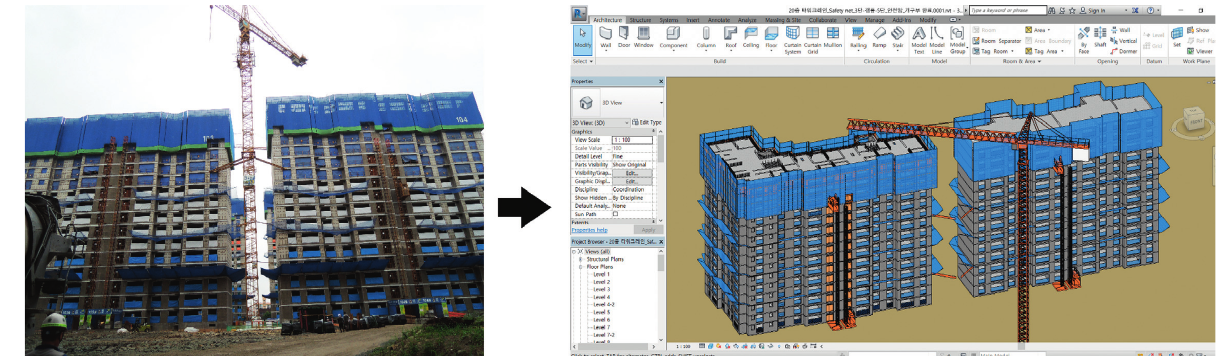
Figure 3: Front view of high-rise apartment buildings and the 3D BIM